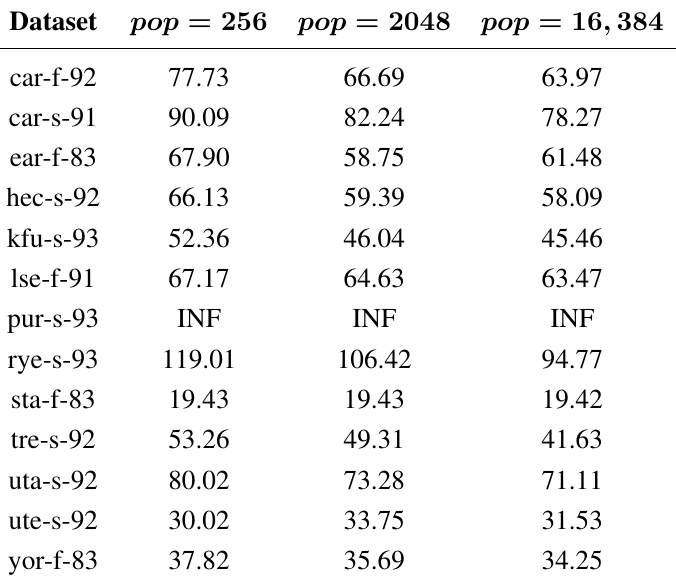
Table 6. Average difference (%) from the best reported solution in the bibliography with the genetic algorithm and a tournament selection size of 10